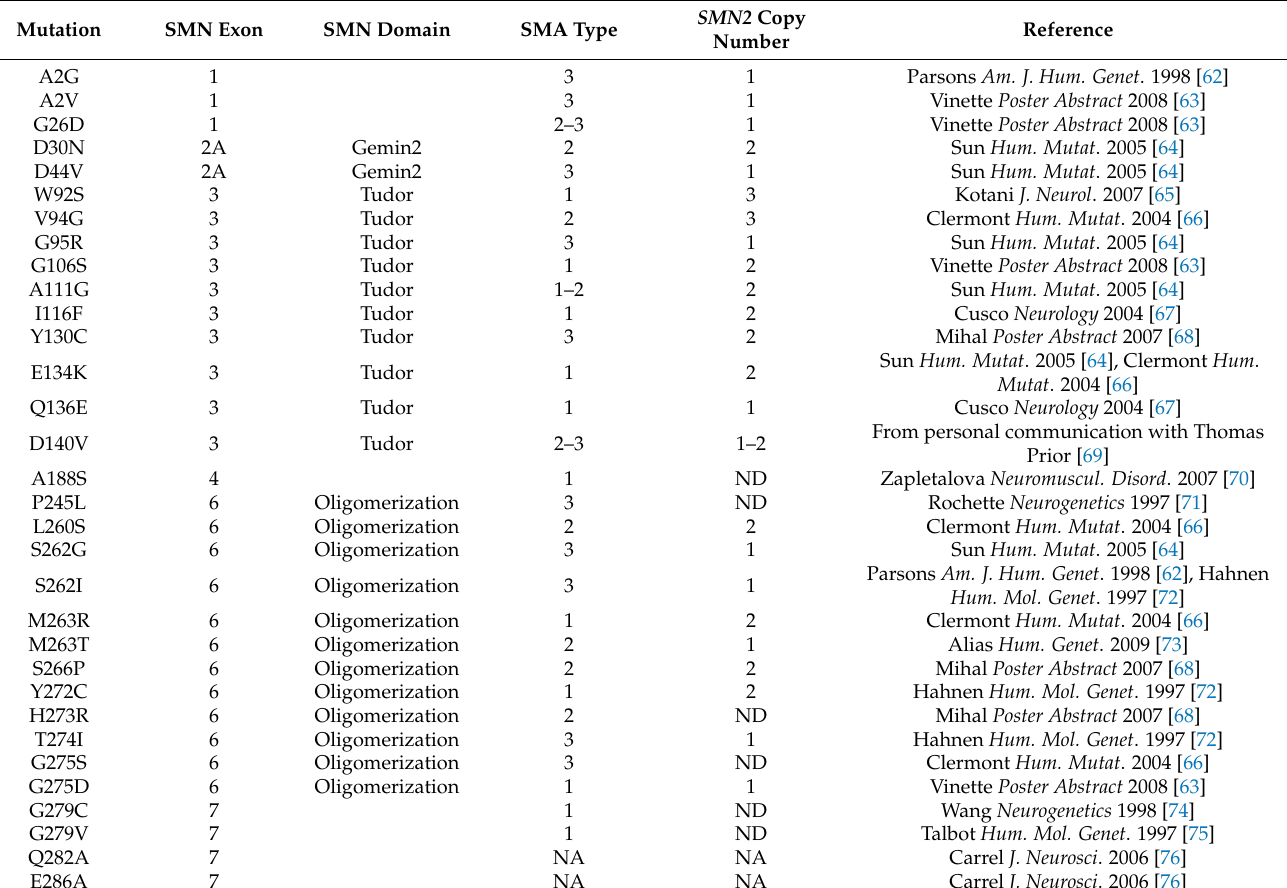
Table 1. Loss of function missense mutations in SMN1 identified in SMA